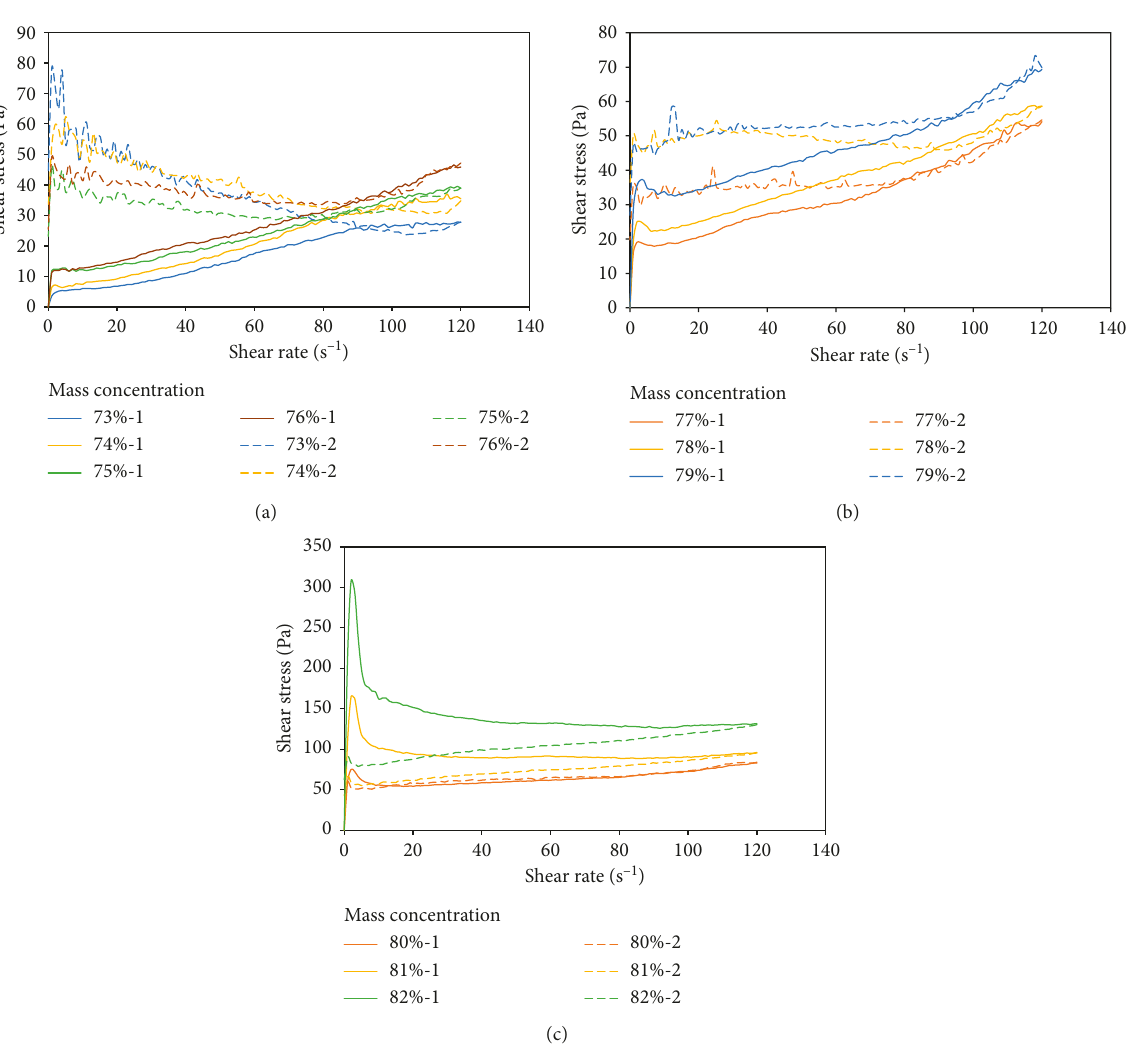
Figure 4: Shear stress-shear rate curve of various slurry concentrations (%-1 solid lines represent 0 ∼ 120s